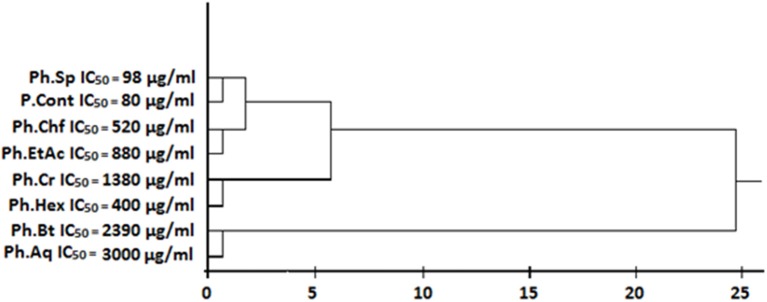
Cluster analysis and dendrogram based on IC50 of different samples in urease inhibitory assay.